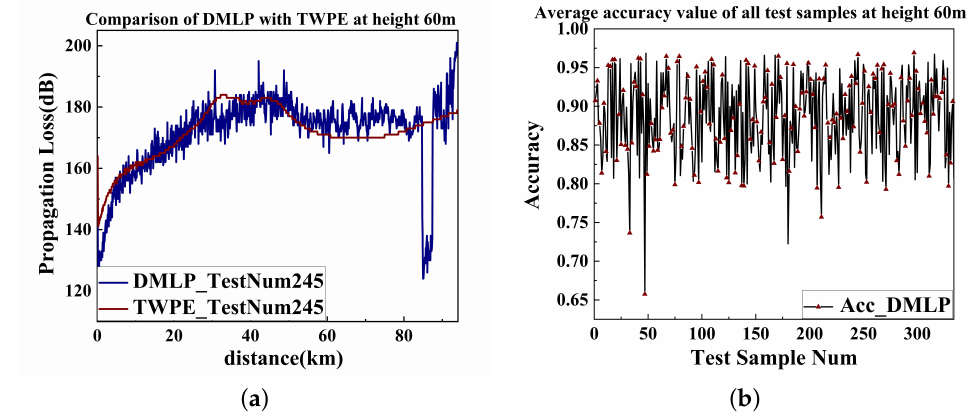
Figure 29. DMLP prediction at a height of 60 m and accuracy distribution. ( a ) PL Prediction using DMLP at an antenna height of 60 m. ( b ) DMLP of PL at a height of 60 m of accuracy on the test samples.